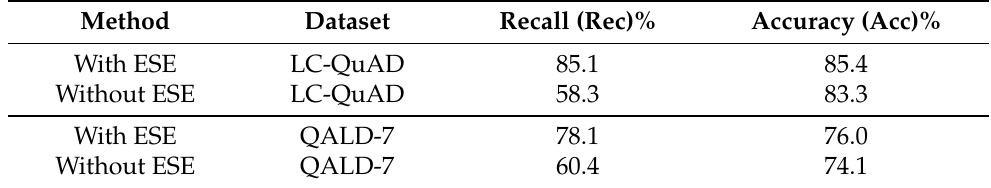
Table 2. Experimental comparison results of With ESE and Without ESE